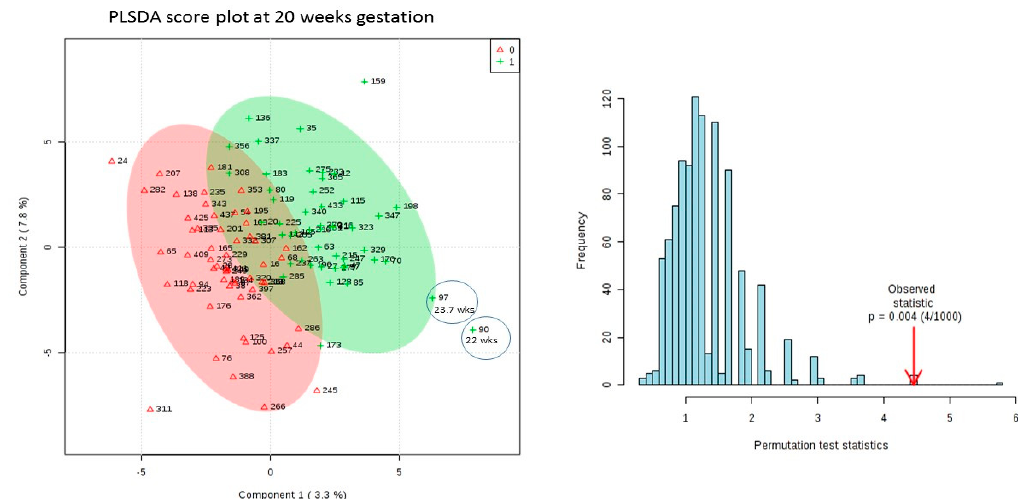
Figure 3. 2-D PLSDA Score Plot from 20 week GA dataset (SPTB versus Age Matched Controls) with results of 2000 times permutation. Cases are green, controls are red. Earliest delivering cases (circled) are furthest from controls. PLS-DA model validation by 1000 permutation tests based on prediction accuracy. The p value based on permutation is p = 0.004 4/1000).